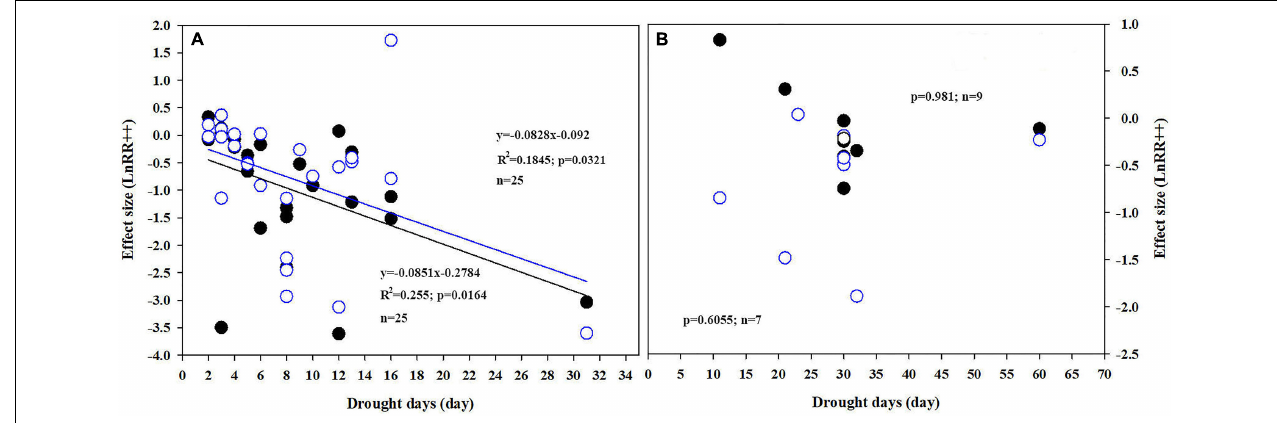
FIGURE 4 | Correlations between drought days and response ratios of P n under closed (A) and open/semi-open, (B) environments under a[CO 2 ] (open circles) and e[CO 2 ] (closed circles).